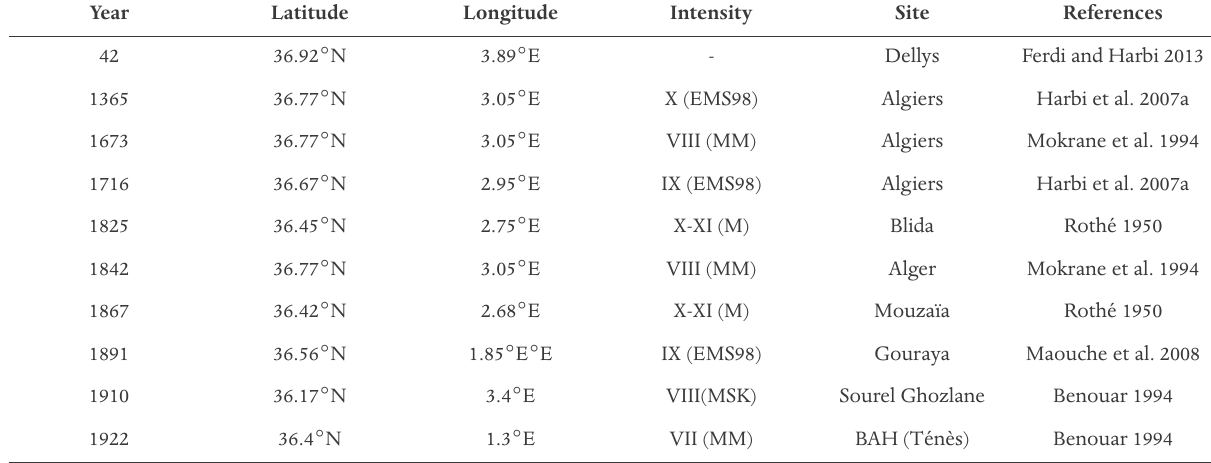
Table 1. List of the most important historical earthquakes mentioned in the Algerian catalogues.